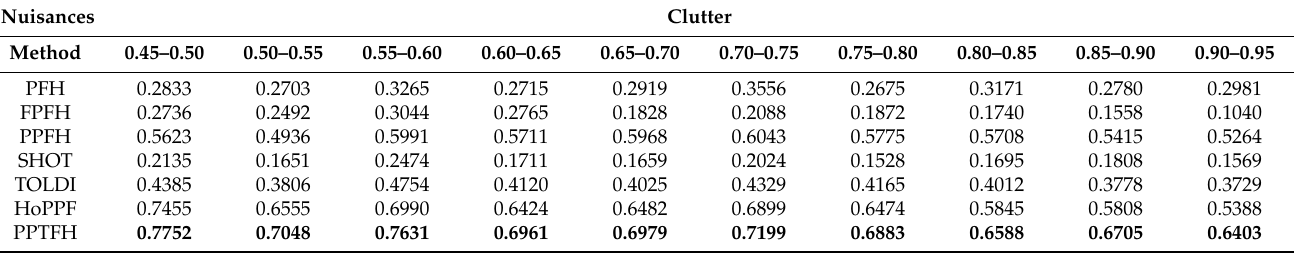
Table 4. Robustness (AUC pr ) to clutter in UWA dataset (1/4 downsample).